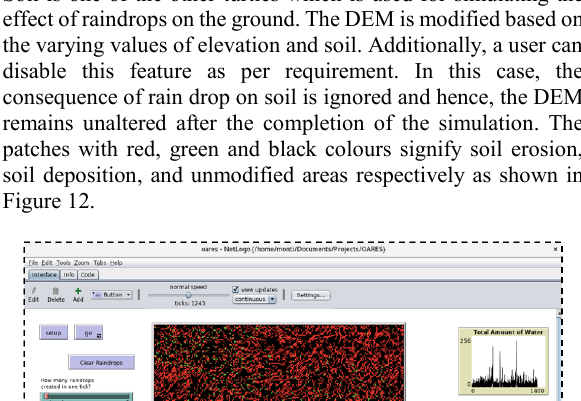
Figure 13. (a) Rainfall – Runoff relationship, and (b) Yearly Rainfall – Runoff plot for Consecutive Variations.